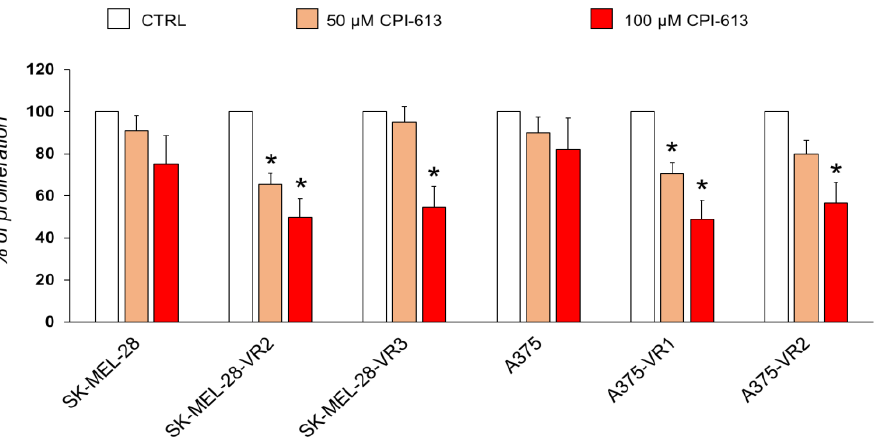
Figure 8. Proliferation rate of melanoma cells untreated (CTRL) or treated with CPI-613 for 48 h. Data are expressed as % proliferation compared to the CTRL (100%) ± SD of three independent experiments (statistical significance: * p < 0.05).